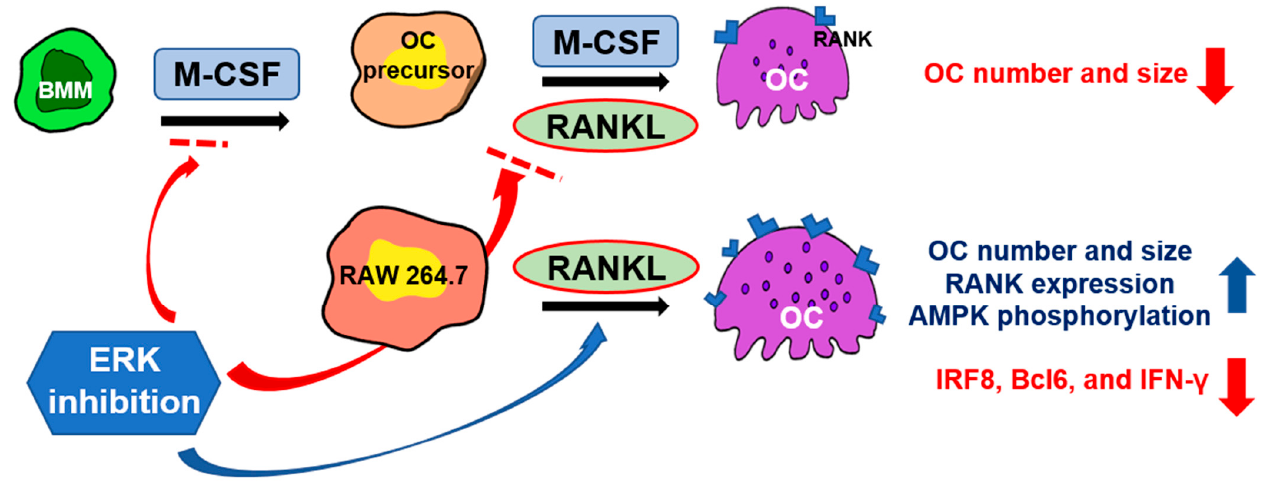
Figure 7. Proposed molecular mechanism that ERK regulates OC differentiation. Inhibition of ERK increased OC differentiation in RAW 264.7 cells by increasing RANK expression and AMPK phosphorylation and inhibiting the expression of negative mediators of osteoclastogenesis, such as IRF8, Bcl6, and IFN- γ .